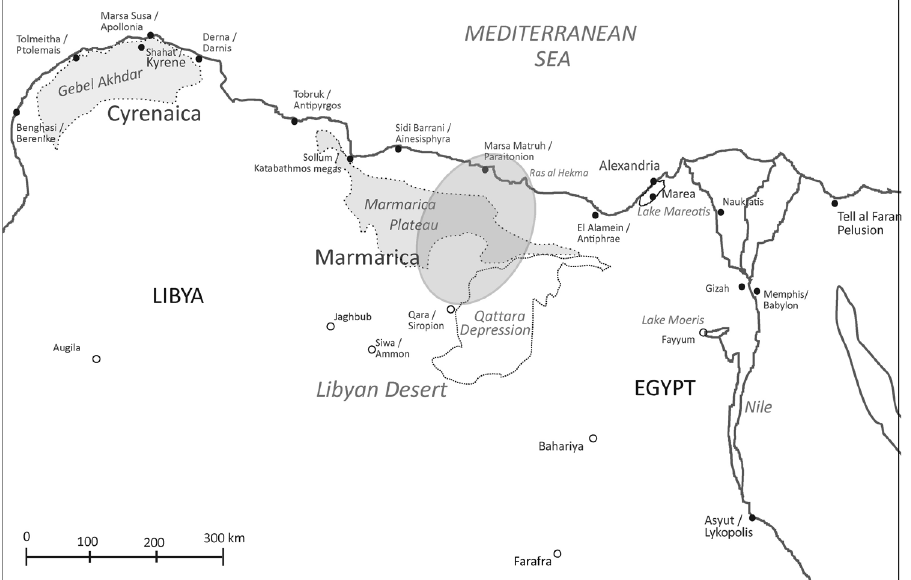
Fig. 1. The Marmarica-Plateau on the northern fringes of the Libyan Desert between Nile Valley, Cyrenaica and Central Sahara (NW-Egypt and NE-Libya). The grey area marks the investigation area. (Anna-Katharina